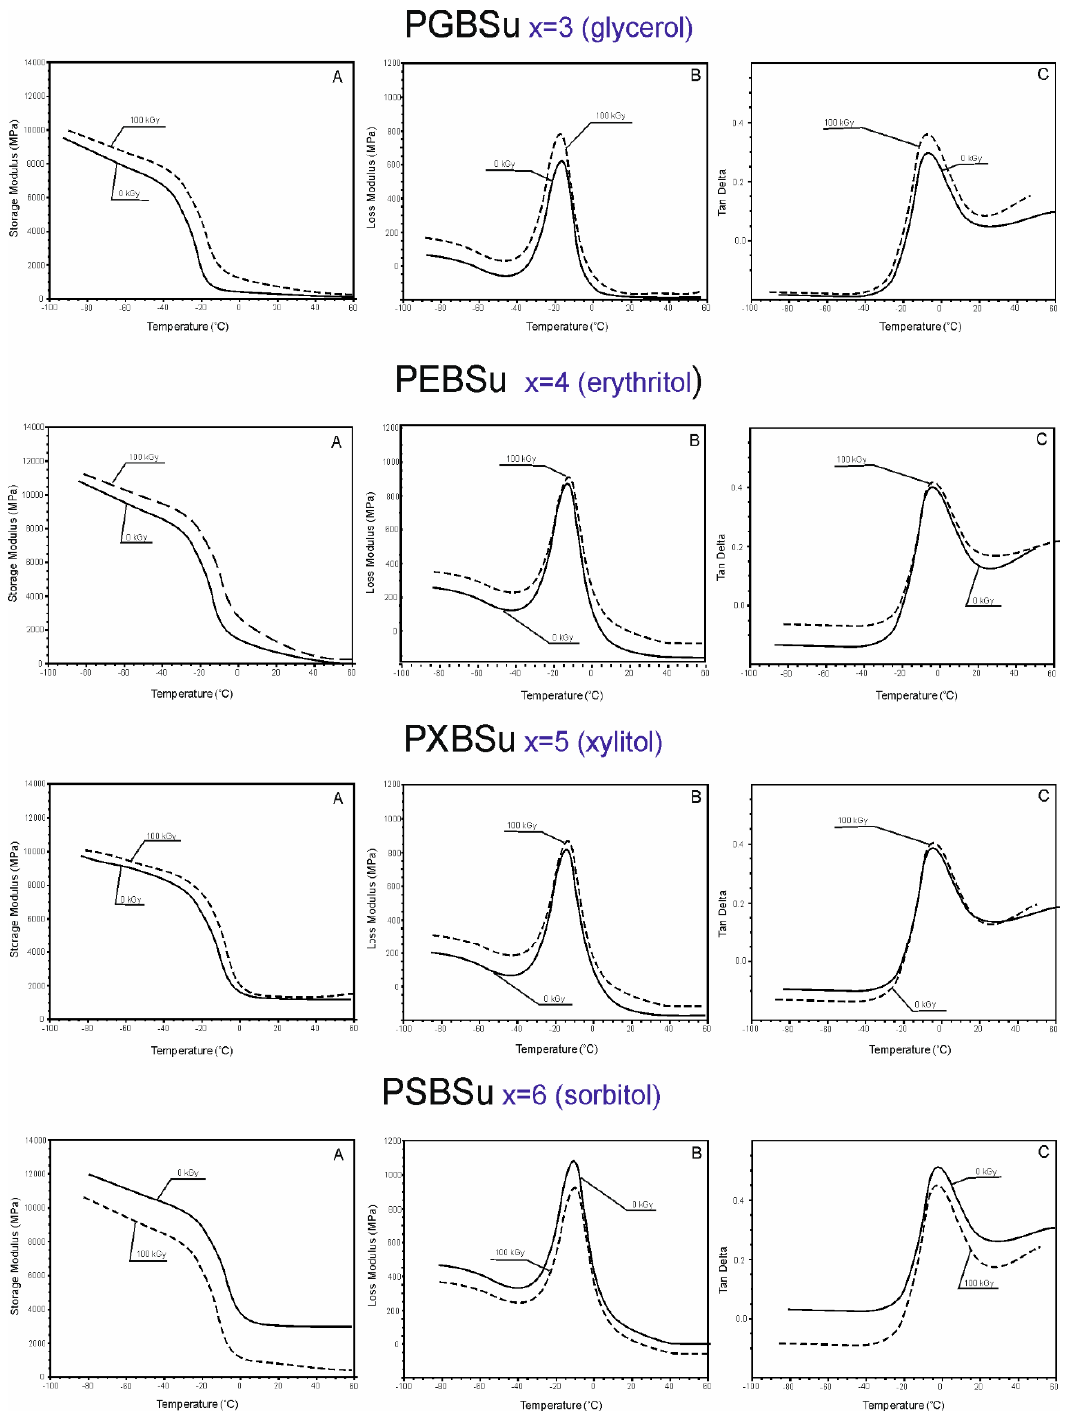
Figure 6. Dynamic thermomechanical analysis (DMTA). ( A ) Storage modulus (E’), ( B ) loss modulus (E”), and ( C ) loss tangent (tan delta versus temperature) for PGBSu, PEBSu, PXBSu, and PSBSu. The values of storage moduli, loss moduli, and tan delta increase after radiation treatment for all materials, except sorbitol, which corresponds to the change of the values of the moduli at 50% and 100% strain as determined by mechanical tests (Section 3.4.). In the temperatures between -100 and -20